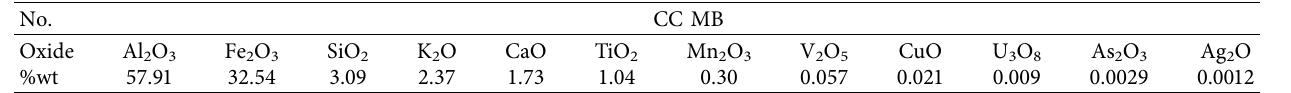
Table 1: Chemical composition of CC